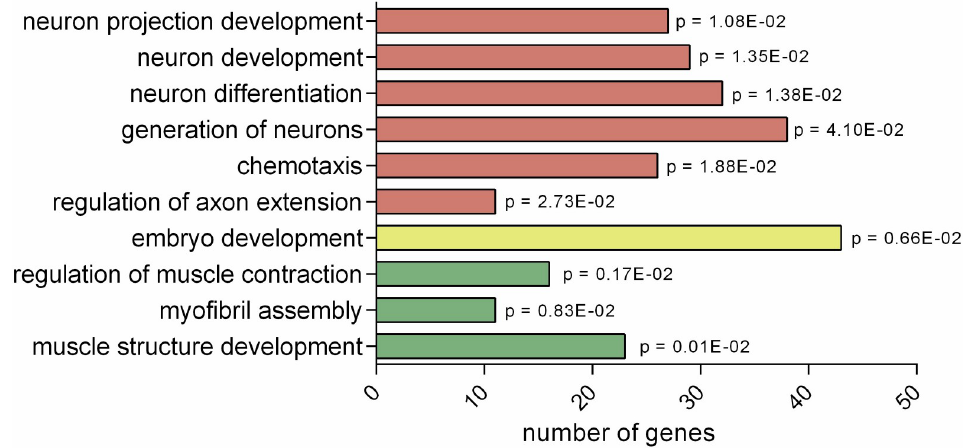
Fig 1. Gene ontology analysis of 872 DamID gene targets in young adult animals. Non-exhaustive list of biological processes overrepresented in CEH-60 DamID targets. False discovery rate corrected p values are shown for the specified biological process. GO terms were grouped thematically (neuron/embryo/muscle development) by color. Gene ontology analysis was carried out with PANTHER 15 using statistical overrepresentation test for biological processes (complete). A complete list of overrepresented GO terms can be found in S3